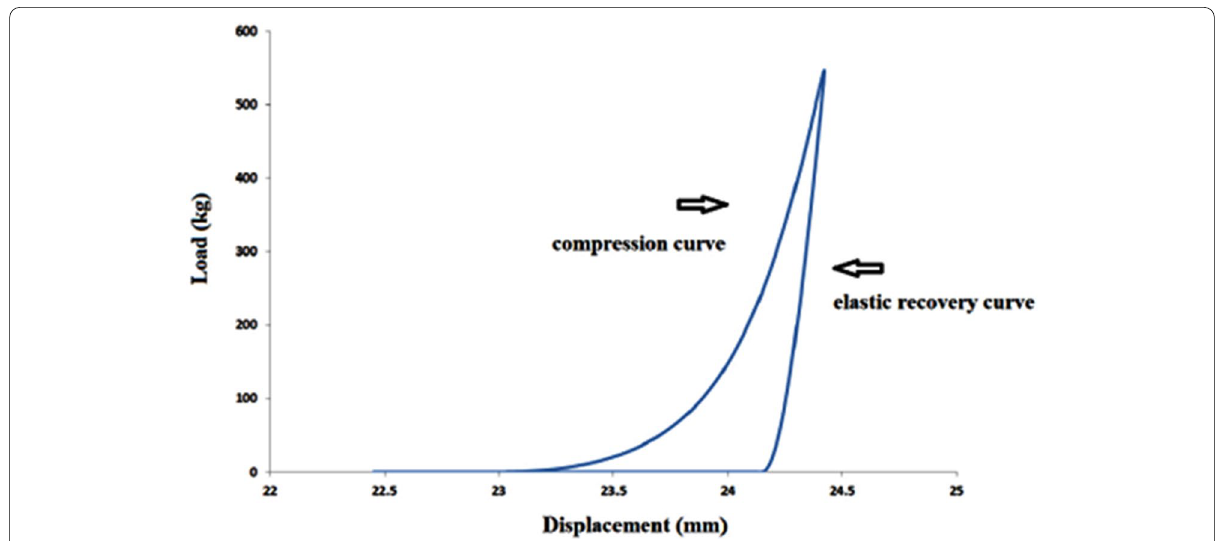
Fig. 1 Typical F-D curve plot representing compression process using